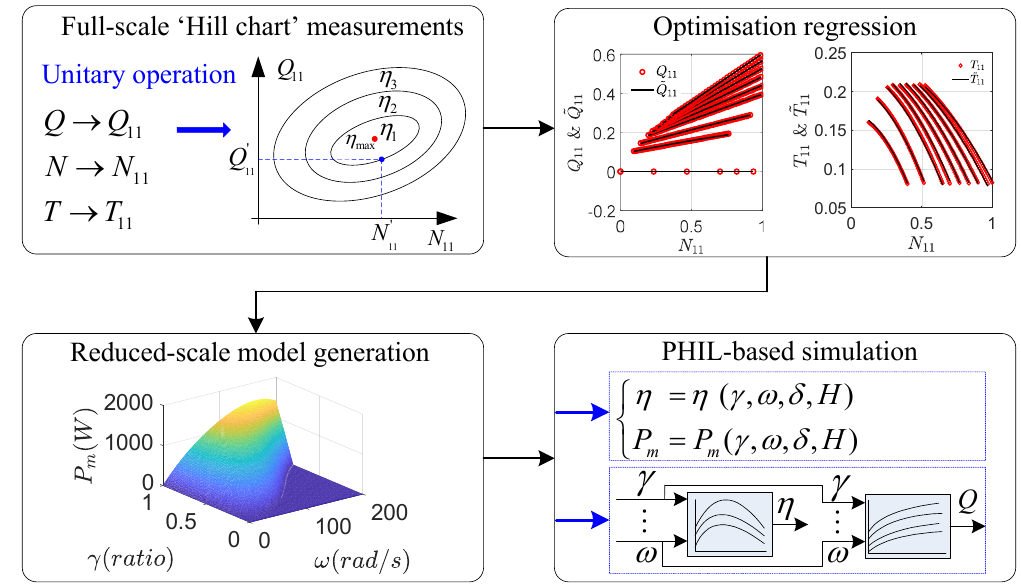
Figure 1. Procedure of a ‘Hill Charts’ based modelling.